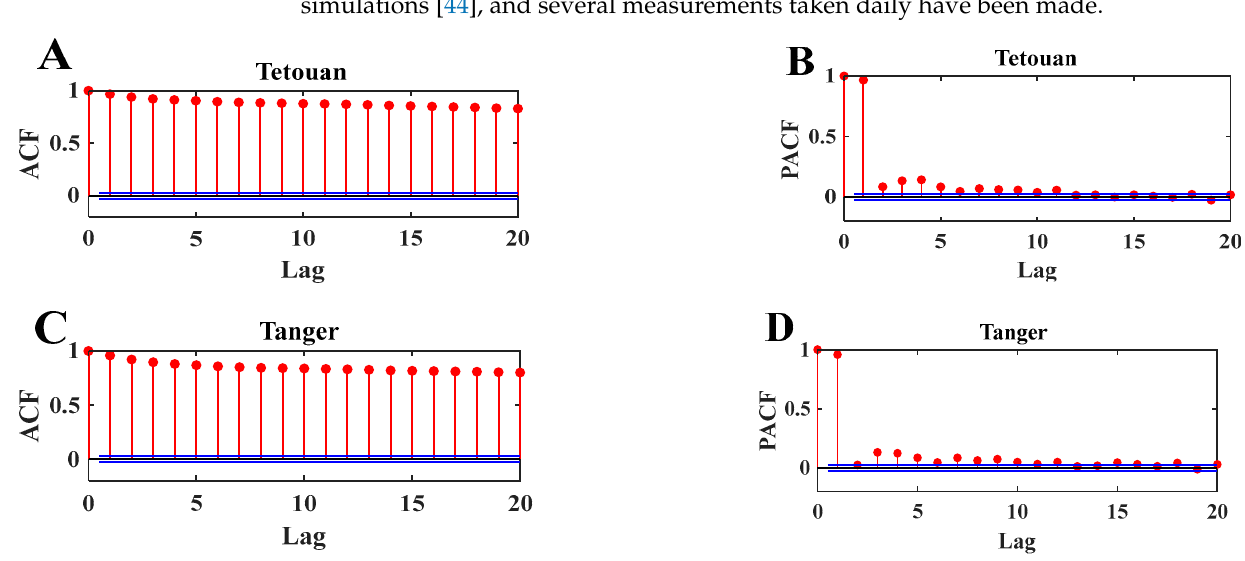
Figure 8. ( A , C ) autocorrelation function (ACF) and ( B , D ) partial autocorrelation function (PACF) of the daily GSR from two cities.